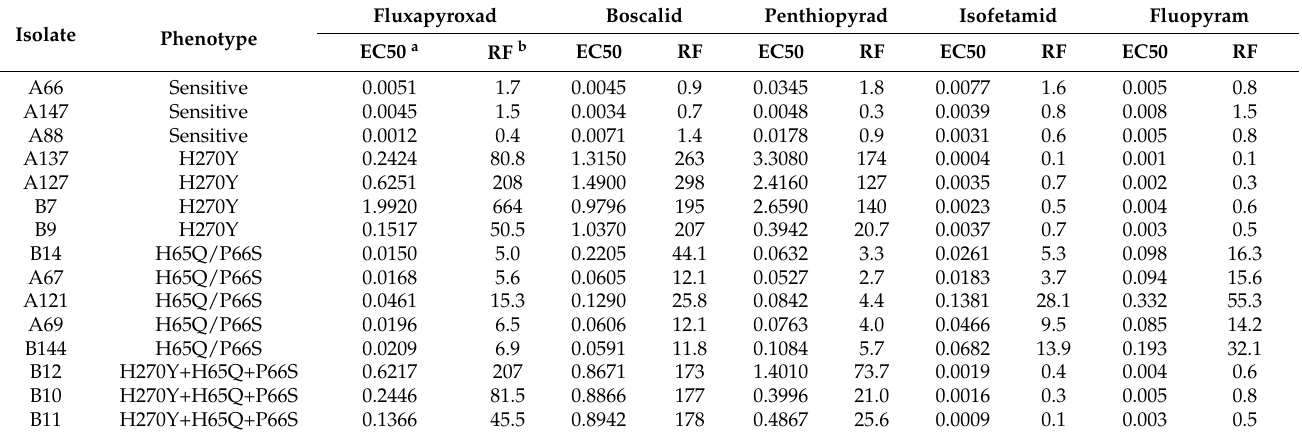
Table 3. EC 50 and resistance factor (RF) values to several SDHI fungicides of sensitive and resistant Aspergillus uvarum isolates, possessing the H270Y mutation in the sdhB gene and/or the H65Q/P66S mutations in the sdhD